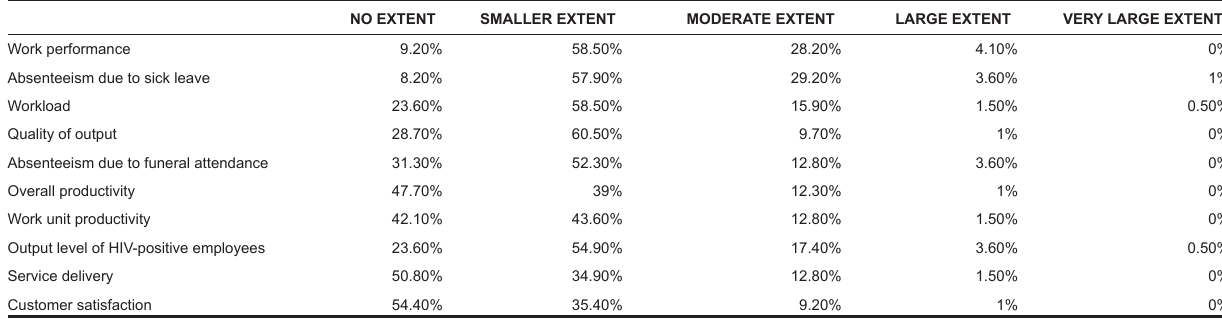
TABLE 7 Impact of HIV/AIDS on productivity levels (% of